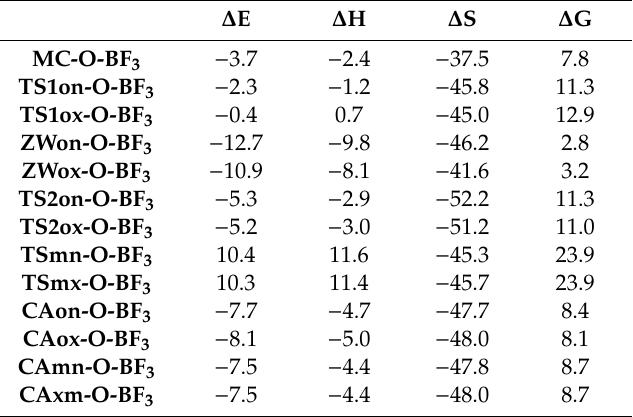
Table 6. B3LYP / 6-311G(d,p) relative energies, ∆ E in kcal · mol − 1 , enthalpies, ∆ H in kcal · mol − 1 , entropies, ∆ S in cal · mol − 1 K − 1 , and Gibbs free energies, ∆ G in kcal · mol − 1 , computed at 25 ◦ C in DCM, of the stationary points involved in the P-DA reaction of Cp 13 with complex 7-BF 3 . ∆